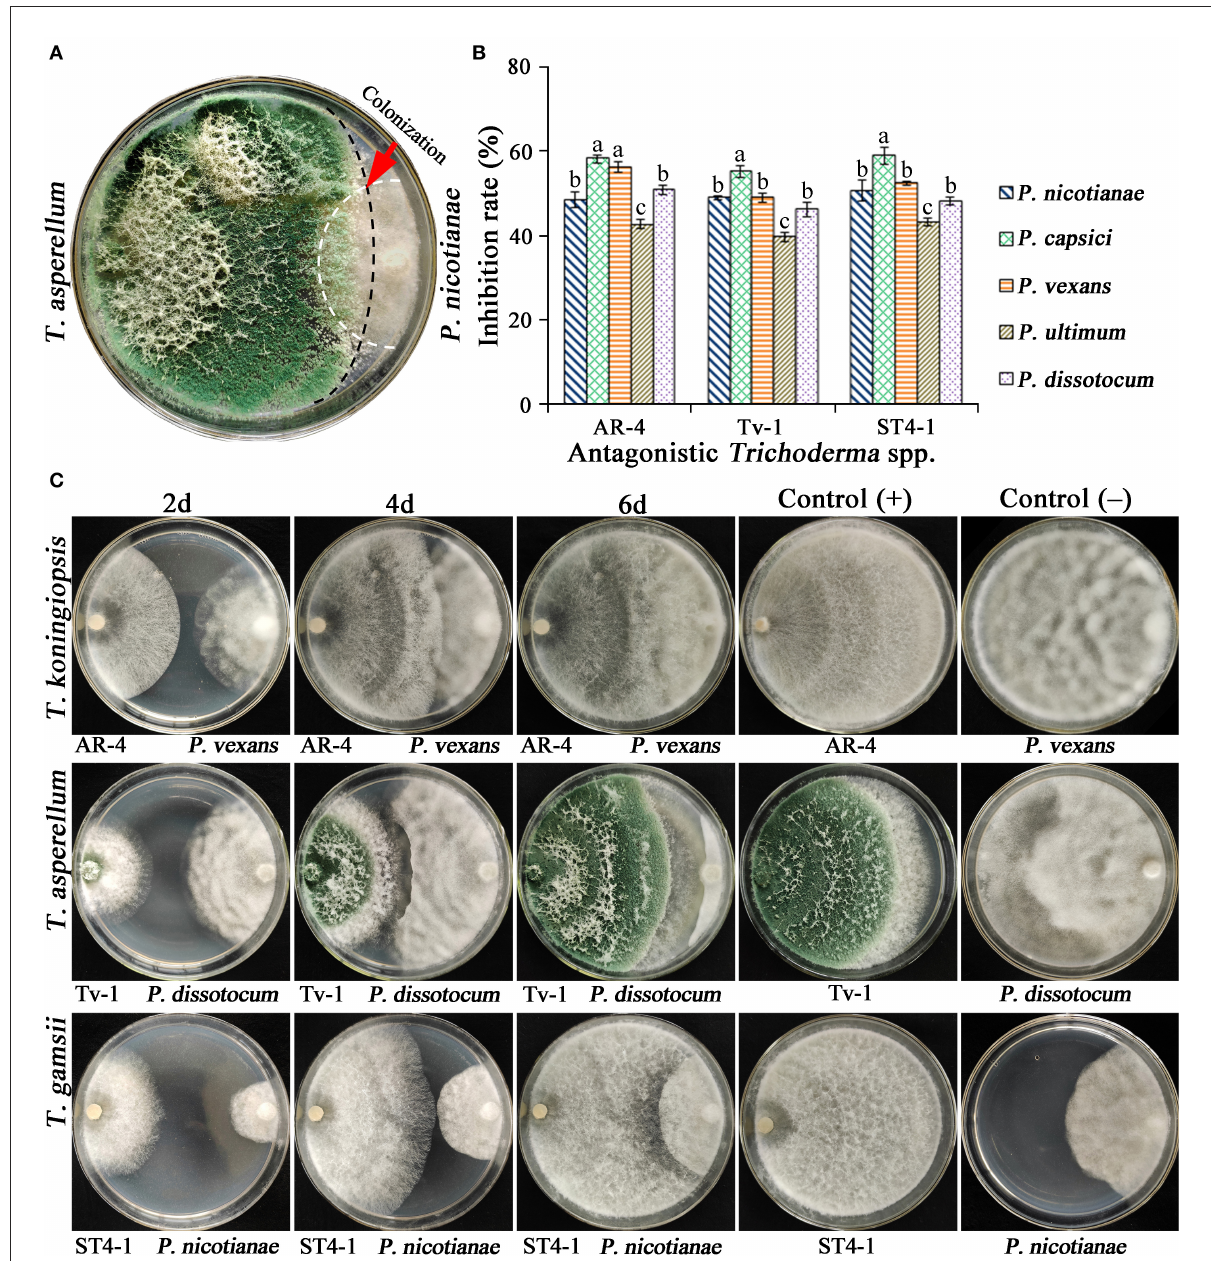
FIGURE1 Antagonism of three antagonistic Trichoderma spp. against oomycete pathogens and inhibition rate. (A) Antagonism of Trichoderma , the red arrow shows the antagonistic zone of T. asperellum Tv-1 on P. nicotianae (5d); (B) the relative inhibition rate of three antagonistic Trichoderma spp. on oomycete pathogens; (C) antagonism of three Trichoderma spp. against oomycete pathogens.